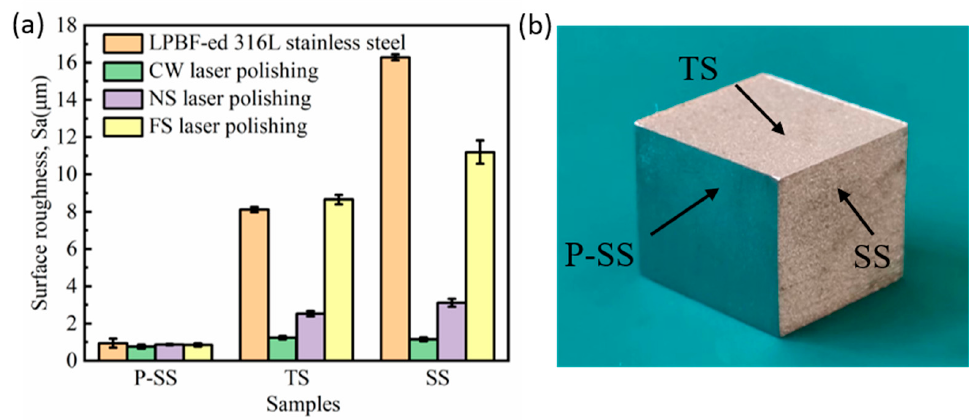
Figure 3. ( a ) Surface roughness of the polished samples with different laser pulse widths. ( b ) Object picture of the LPBF-ed 316L stainless steel.